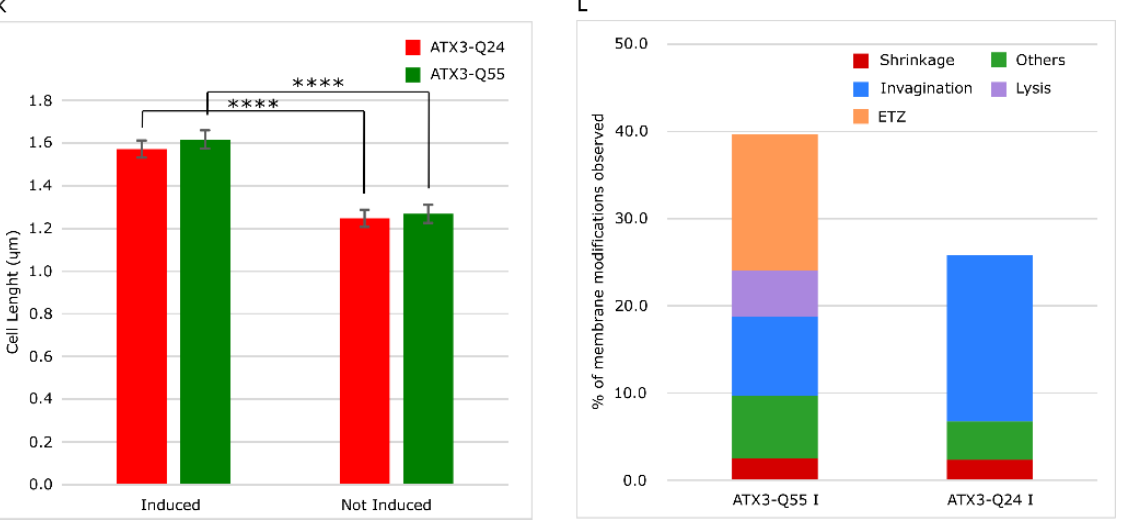
Figure 8. Transmission Electron Microscopy micrographs and analysis of E. coli ATX3-Q24 and ATX3-Q55 expressing strain; 2 OD of induced and NI cells were collected at 5 h of induction and treated as reported in materials and methods (par. 4.7). ( A ) ATX3-Q24 not induced cells. ( B–E ) ATX3-Q24 induced strain. ( F ) ATX3-Q55 not induced strain. ( G–J ) ATX3-Q55 induced strain. IB, inclusion body. Arrows indicate vesicles. * DNA condensation. ** Cytoplasmatic IBs. *** Outer membrane detachment. Dashed arrows indicate membrane destruction and cell lysis. ( K – L ) Cell length and classification of membrane alterations of E. coli Rosetta strains expressing ATX3-Q24 (black bars), ATX3-Q55 (light grey bars). Cell growth 5 h after IPTG addition (I), or not (NI), were prepared for thin-layer EM microscopy. Cell length (K) was automatically measured after TEM imaging using ImageJ software. Significant differences among groups (ATX3-Q24 NI, ATX3-Q55 NI, ATX3-Q24 I, ATX3-Q55 I) were assessed by factorial analysis of variance (ANOVA) followed post-hoc Tukey’s HSD test. Error bars represent error standard ( n = 333). **** p < 0.0001. Membrane alterations (L) were classified as shrinkage (red), invaginations (blue), electron transparent zone (ETZ; orange), lysis (light violet) and not distinguishable (ND, not distinguishable between shrinkage and invagination; green). Data are expressed as percentage on total cells analyzed ( n = 333).